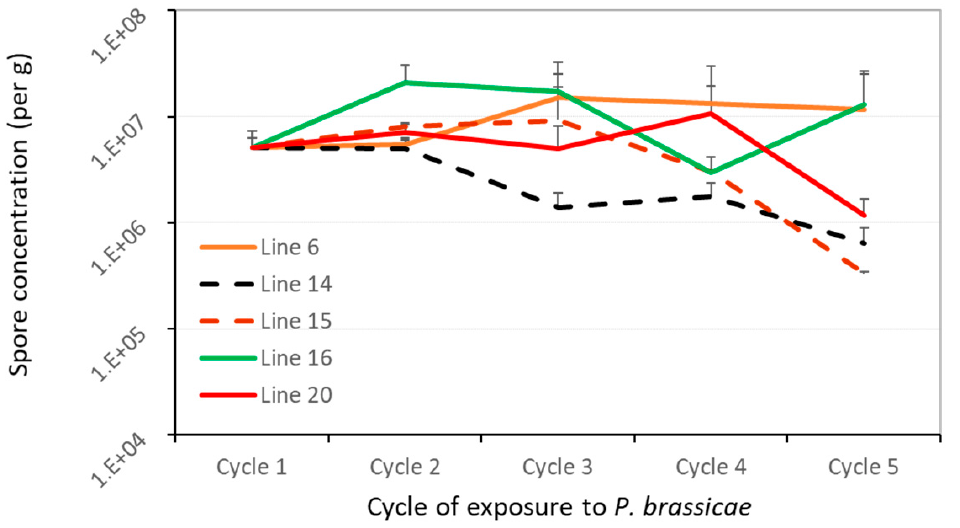
Figure 4. Mean resting spore concentrations in soil quantified with qPCR at the beginning of each cycle of exposure to L-G3 of pathotype X for five selected canola lines carrying a single or double CR genes. Data from two repetitions of the study were combined ( n = 6). The lines 14 ( Rcr1 + Crr1 rutb ) and 15 ( CRa M + Crr1 rutb ) were moderately resistant (in dash lines), while the rest were susceptible (in solid